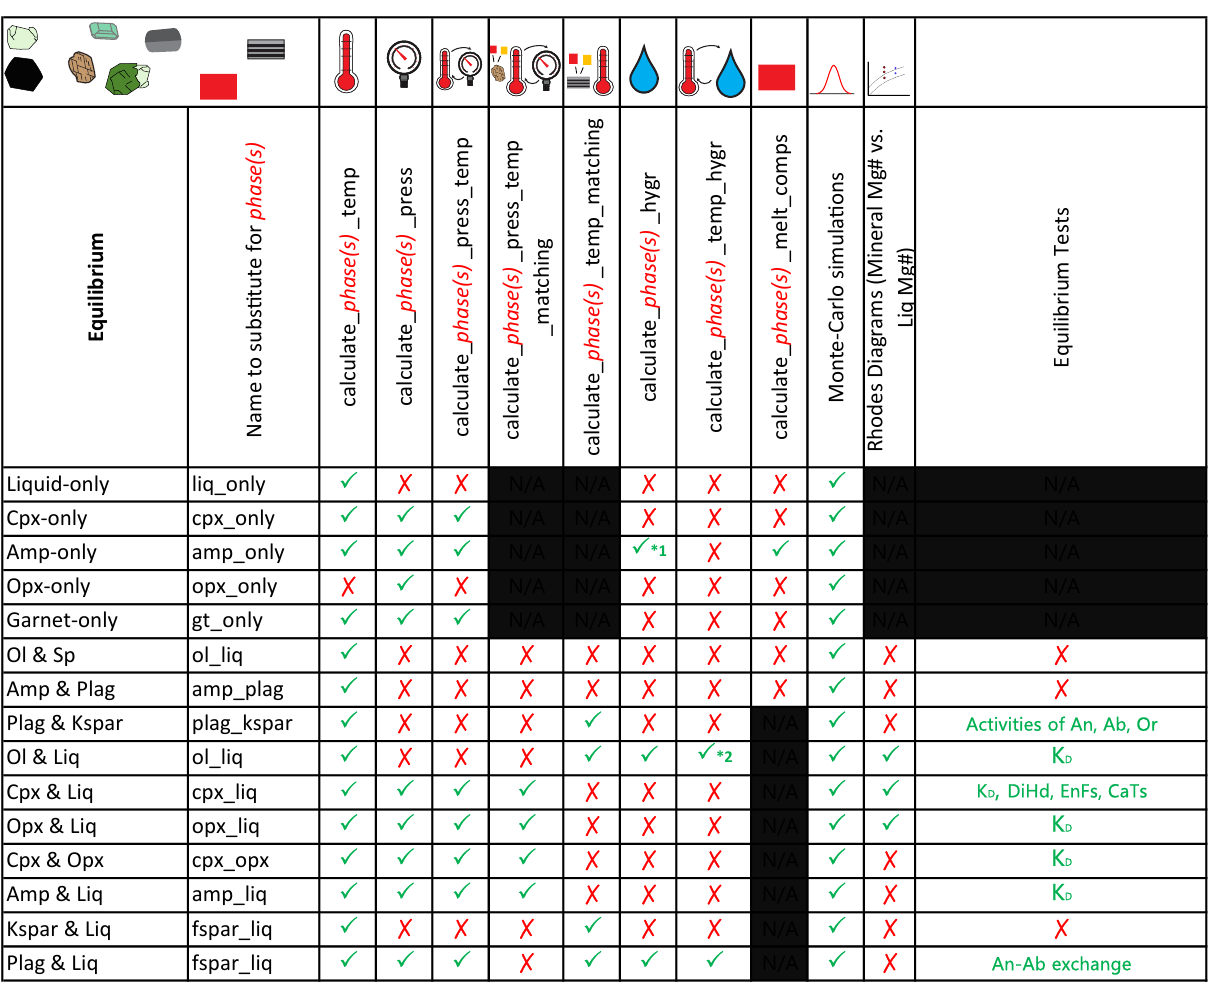
Figure 3: Summary table of functions for each phase. *1: While Amp-only hygrometers exist, in Thermobar , calculations should be performed using the calculate_amp_only_melt_comps function instead. *2: As the Ol-Liq hygrometer is not T -sensitive, there is no need to iterate. Thus, users should use the calculate_ol_liq_hygr function and specify equationT as an